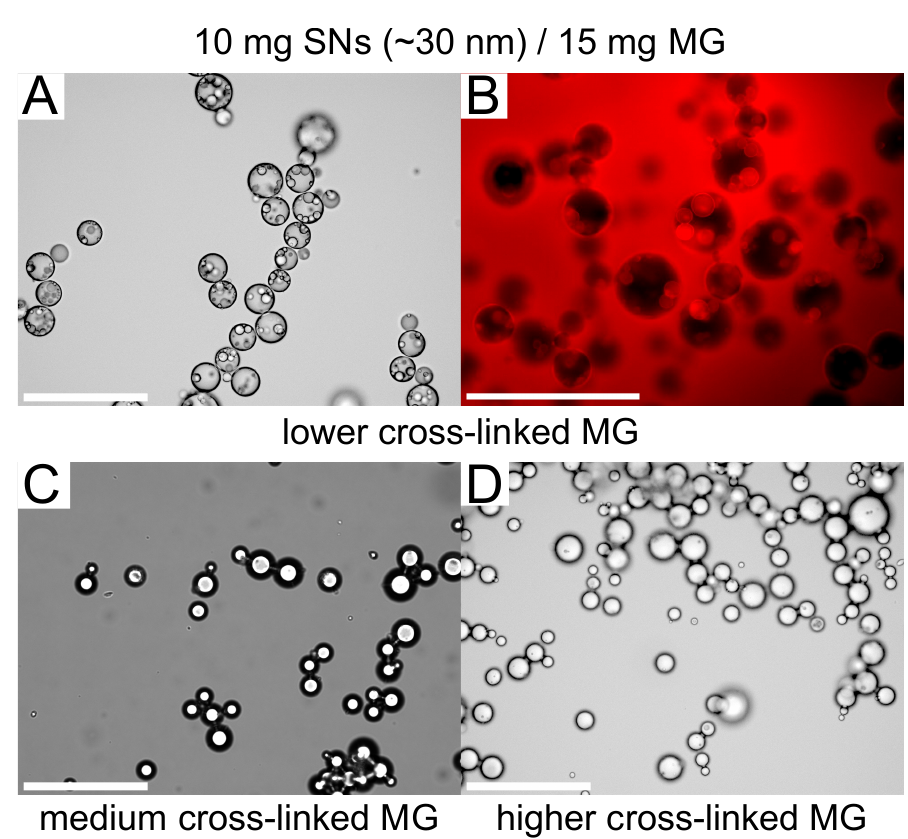
Figure 4. Micrographs of the emulsions with the highest amount of present MGs (15 mg). The o/w/o emulsion type for the emulsions prepared with the lowest cross-linked MG ( A ) was proven by dying the oil phase with nile red ( B ). For the higher crosslinked MGs ( C , D ), no double emulsions formed. The white bars represent 200